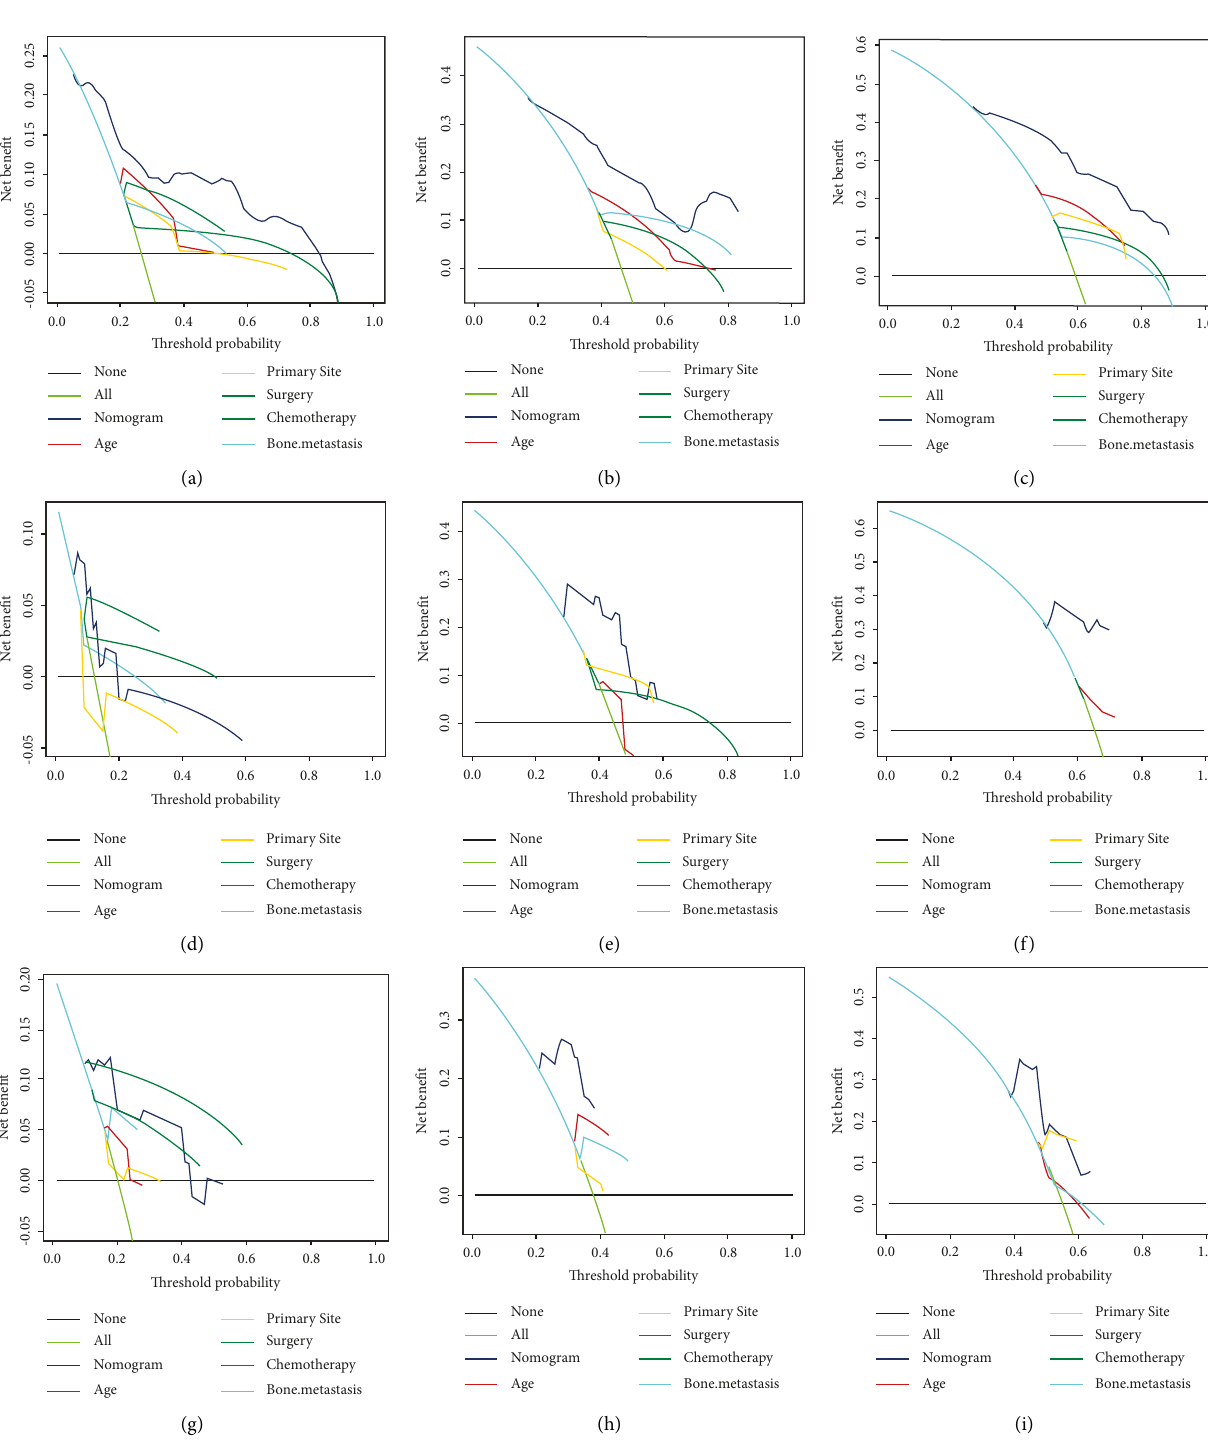
Figure 7: Comparison of decision curve analysis between the prognostic nomogram and single independent factors. 12-month, 24-month, and 36-month survival rates in the training set (a-c), internal validation set (d-f), and external validation set